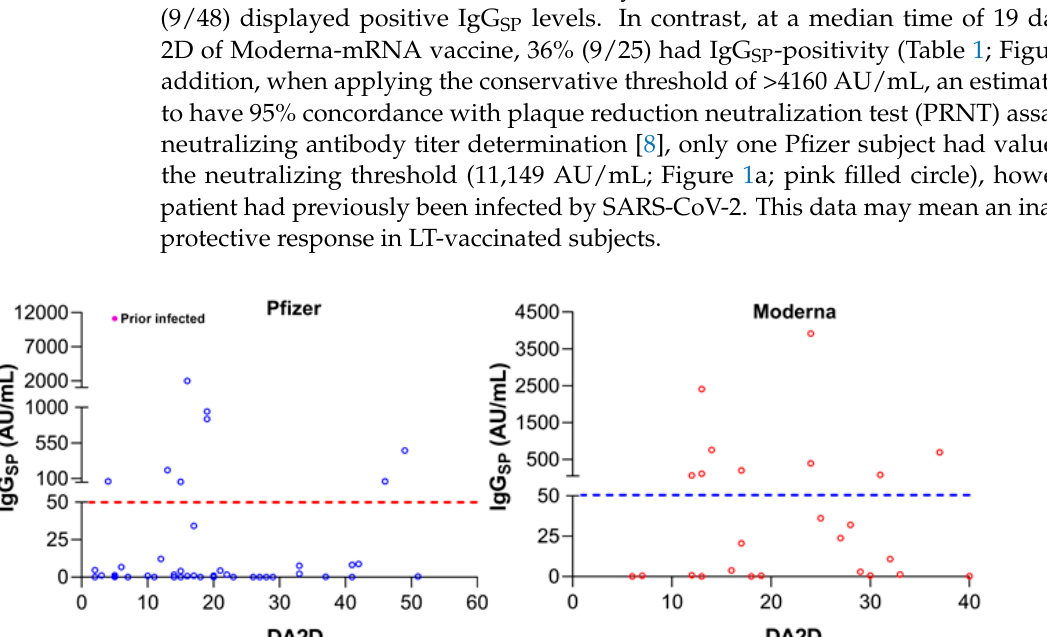
Table 1. Demographic and clinical characteristics of study participants stratified by spike ‐ specific IgG (IgG SP ) antibody response after two ‐ dose ‐ COVID ‐ 19 vaccination.